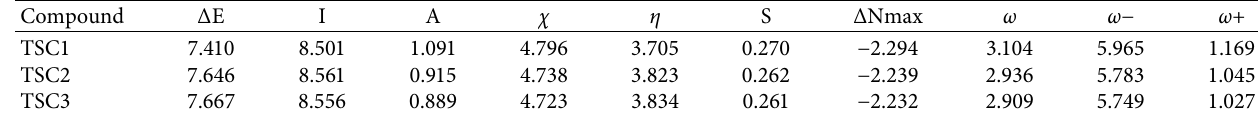
Table 2: Calculated quantum chemical parameters of the synthesized thiosemicarbazone